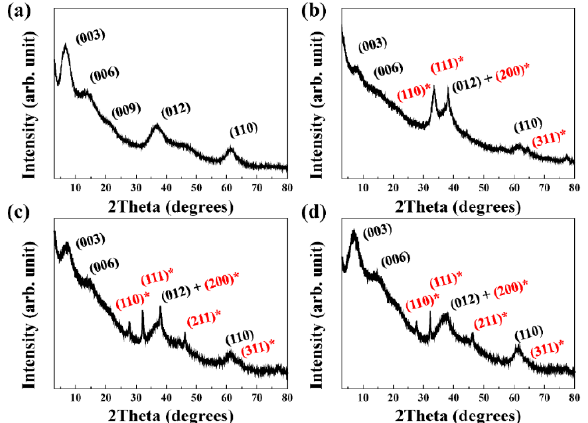
Figure 1. X-ray diffraction (XRD) patterns of ( a ) pristine MgAl–citrate layered double hydroxide (LDH), ( b ) Silver oxide nanoparticle (SONP)@LDH-1, ( c ) SONP@LDH-1/3 and ( d ) SONP@LDH-1/10 (black (hkl) notation: LDH, red(*) (hkl) notation: silver oxide).